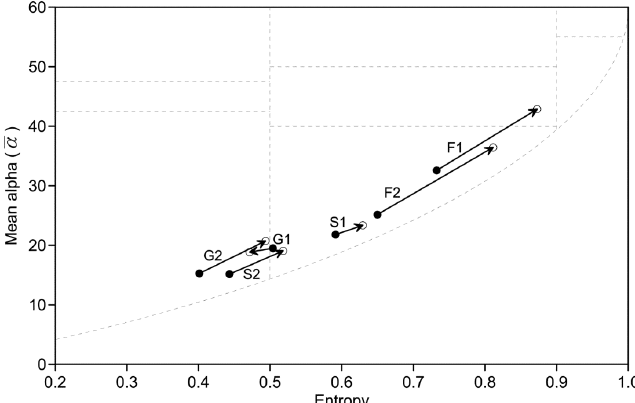
Figure 5. Movement of mean (cid:1834) and (cid:2009)(cid:3364) values of the test sites between frozen (closed circle) and thawed (open circle) conditions. (open circle)